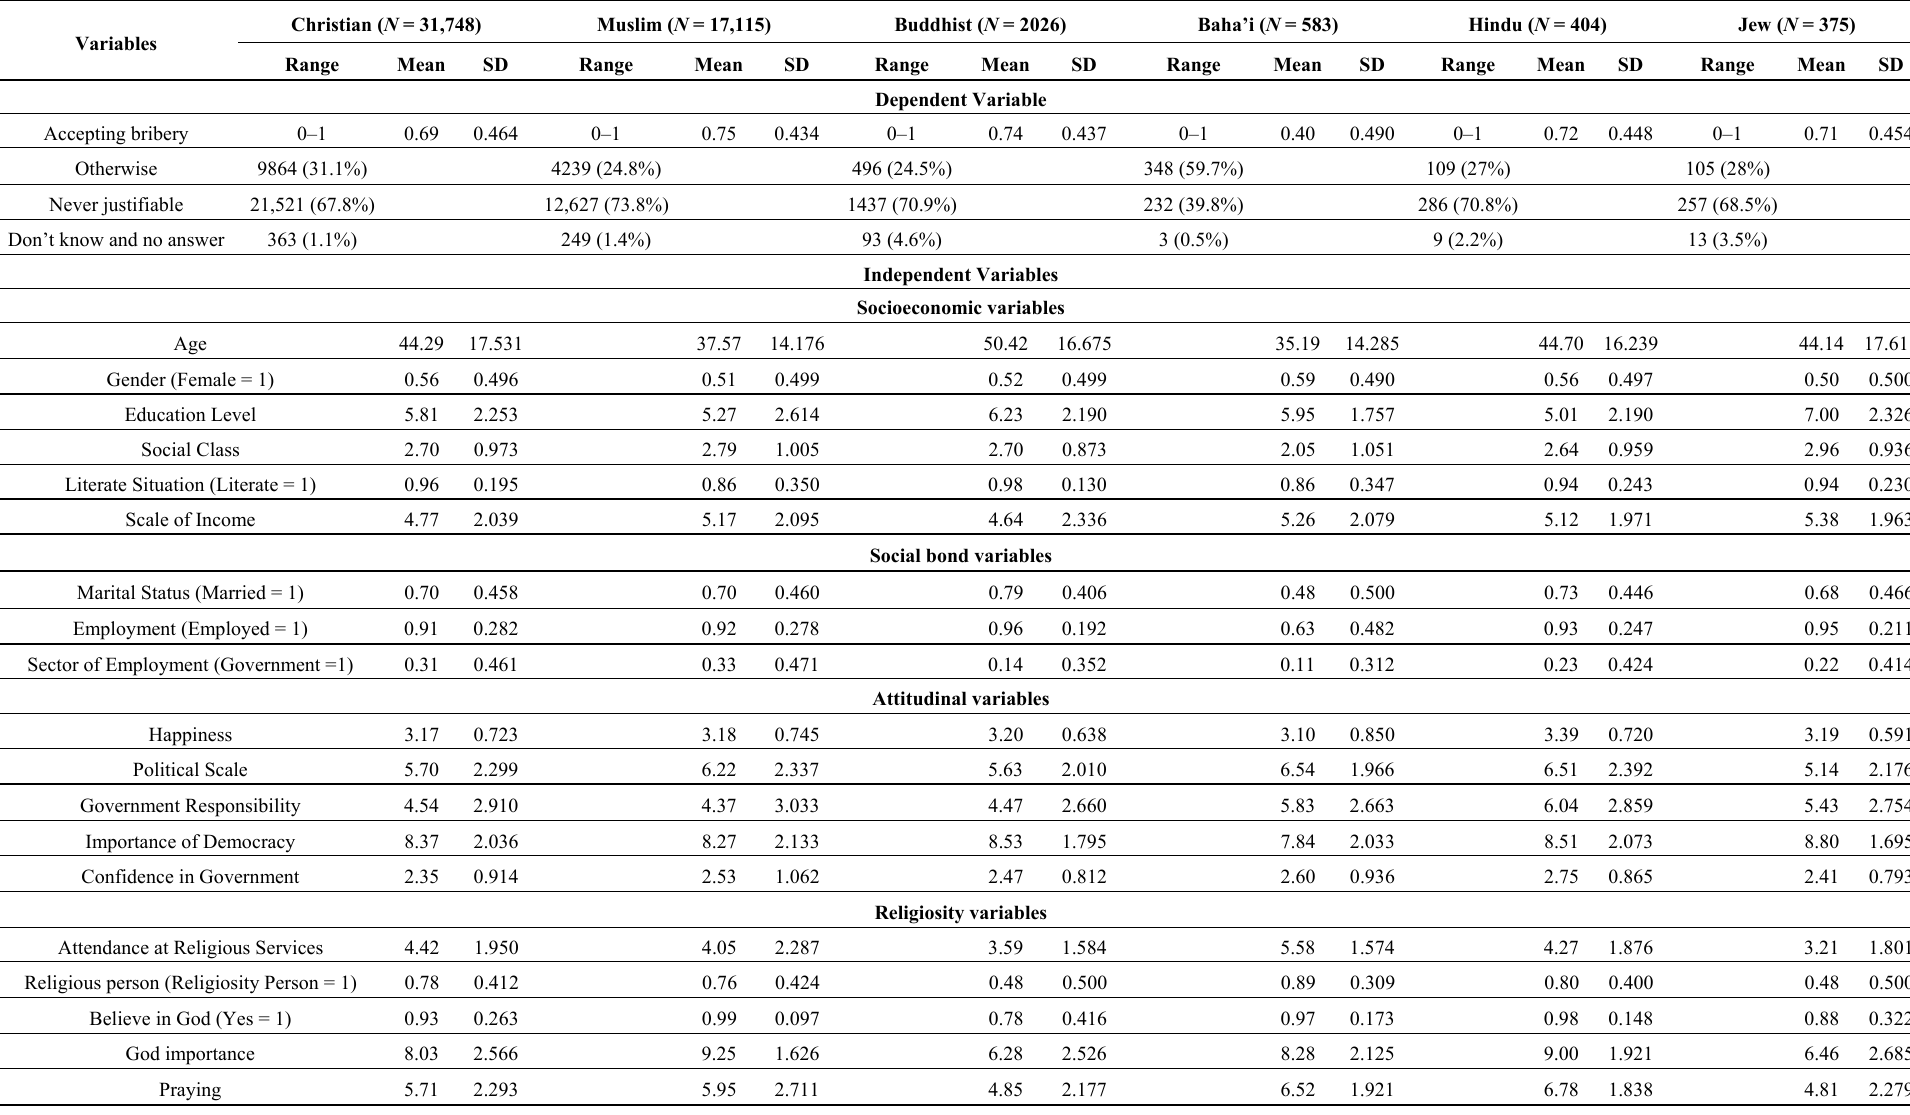
Table 1. Descriptive statistics of the sample by religions ( N =